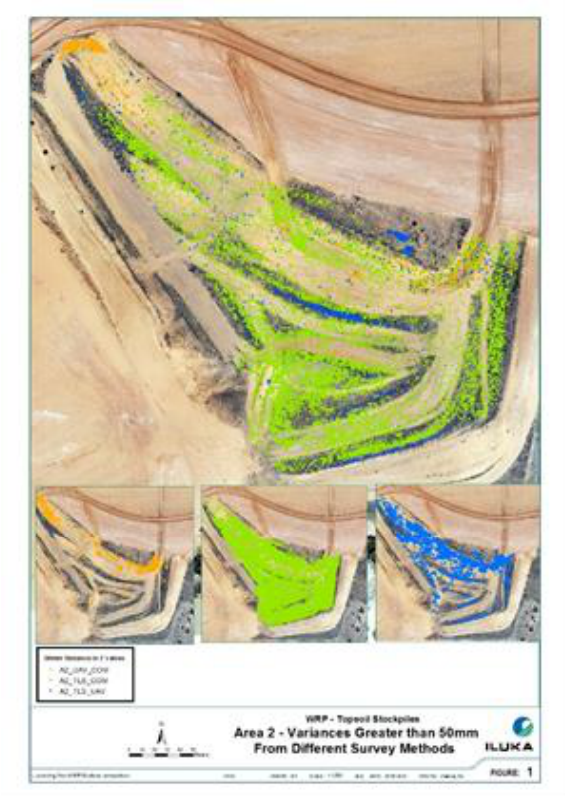
Figure 5: Map of Area 2 indicating the +/- 0.05m variations between the TLS, UAV and Combined Surface Models.